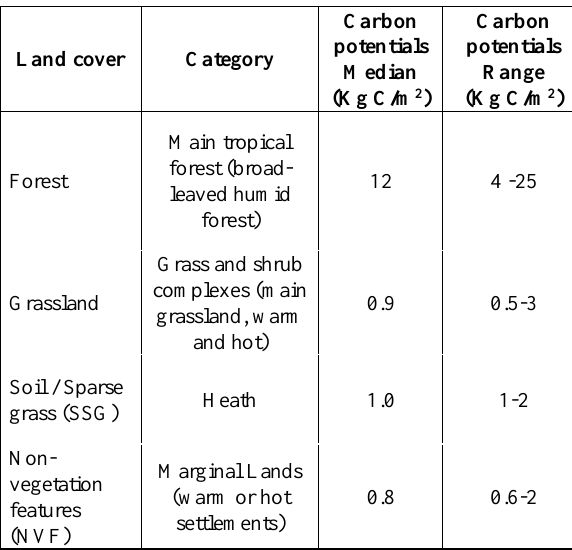
Figure 3 The results of land cover classifications in 1989 (a) and 2001 (b). Forest (green); Soil / Sparse grass (sienna), Grassland (yellow), Non-vegetation features (magenta).